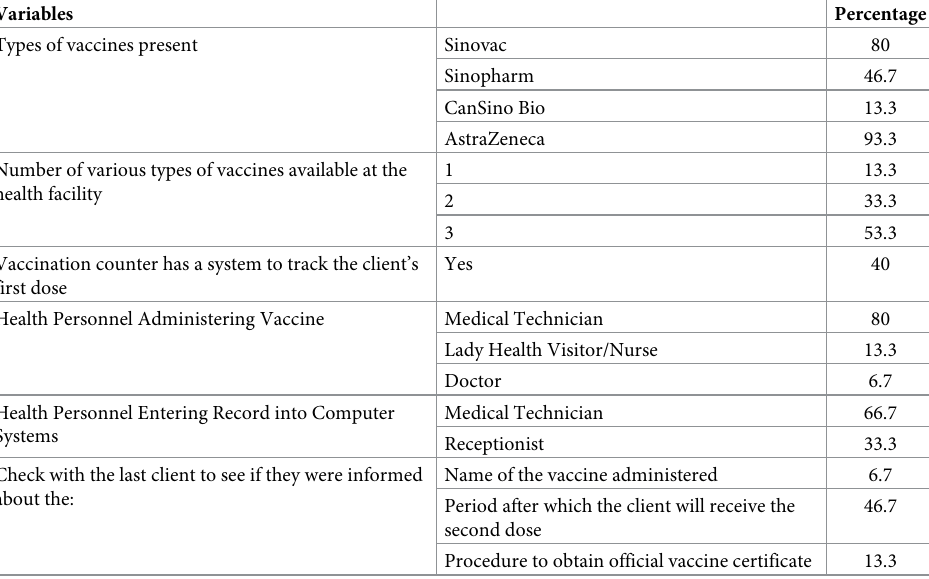
Table 1. Information about the Adult Vaccination Counters (N = 15).